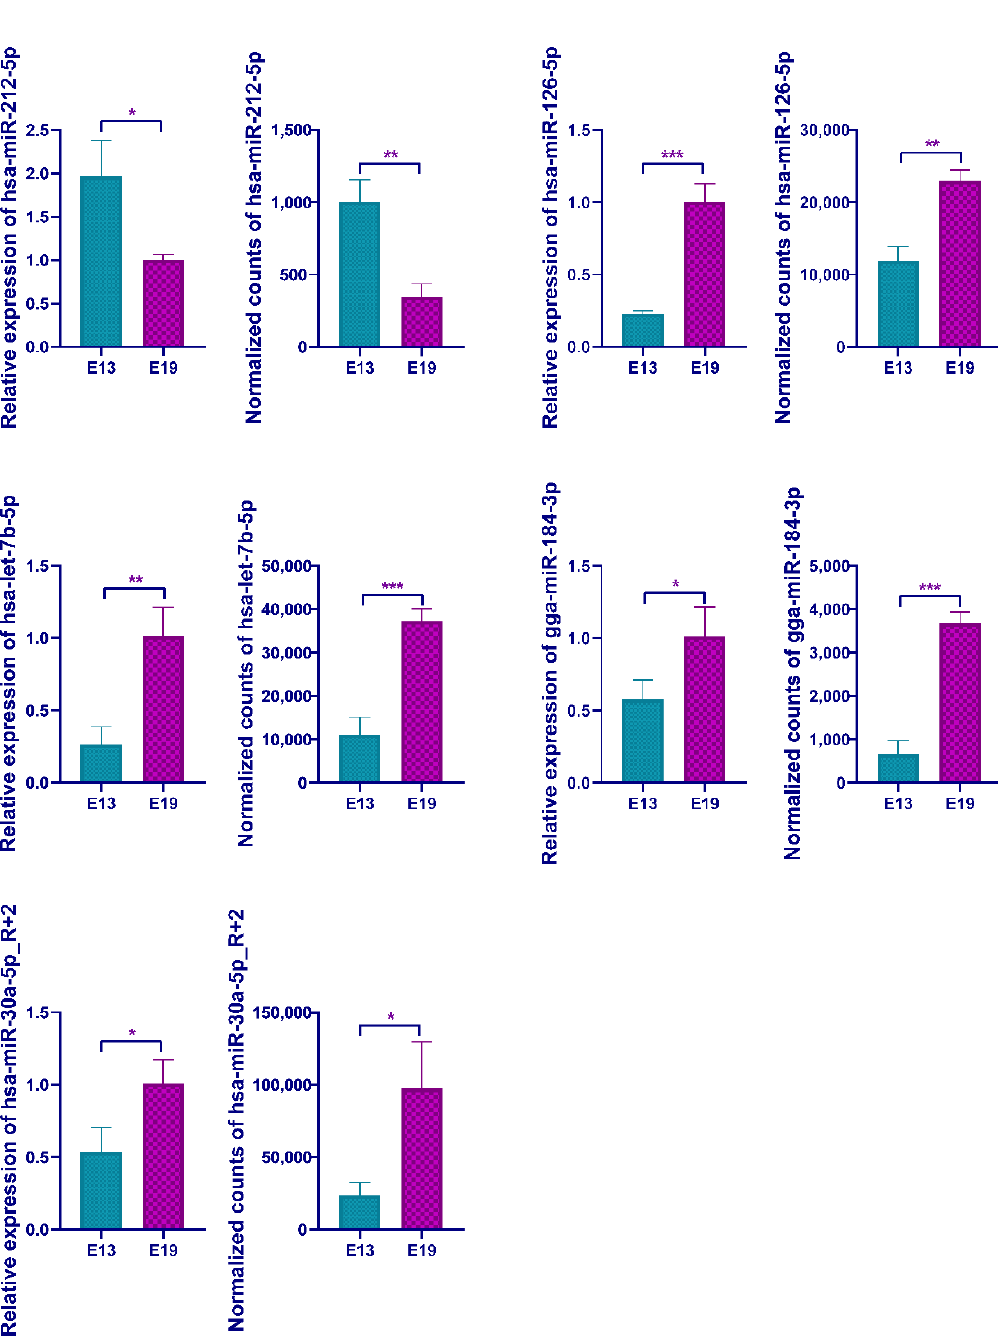
Figure 4. qRT-PCR validation of the identification of differentially expressed miRNAs. In all panels, values are presented as mean ± SEM. * p < 0.05; ** p < 0.01; *** p < 0.01.